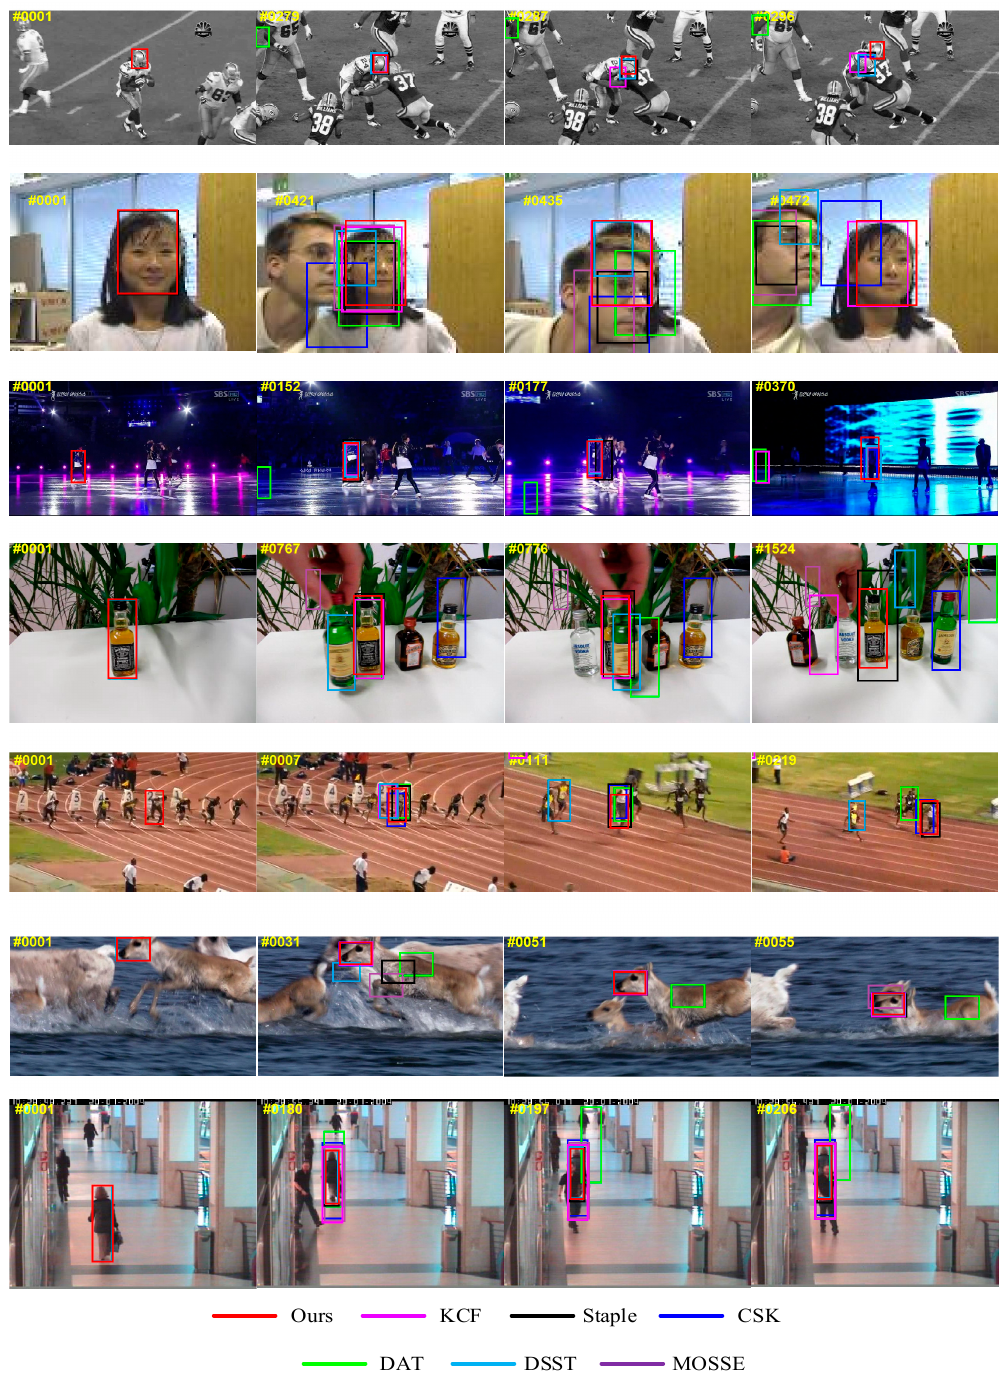
Figure 2. Qualitative comparisons. We list the tracking results of the representative frames of nine sequences ( Basketball, Coupon, Football, Girl, Shaking1, Liquor, Bolt2, Deer and Walking2 from top to bottom ) for seven trackers, and our results are marked with red solid